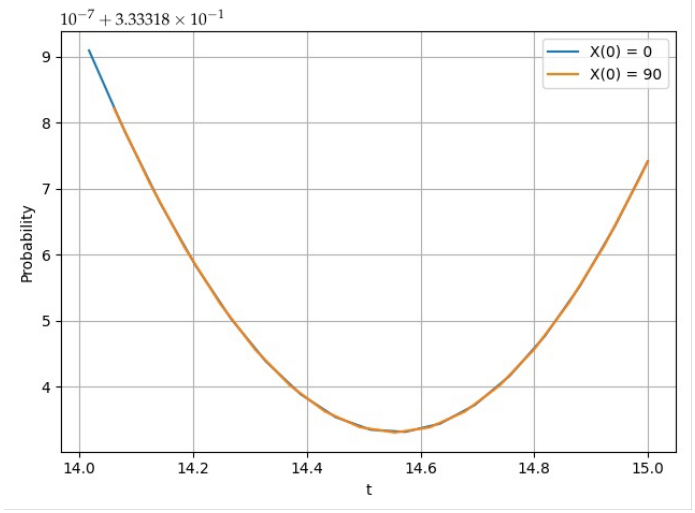
Figure 3. Approximation of the limiting probability of an empty queuing system for t ∈ [ 14,15 ] .